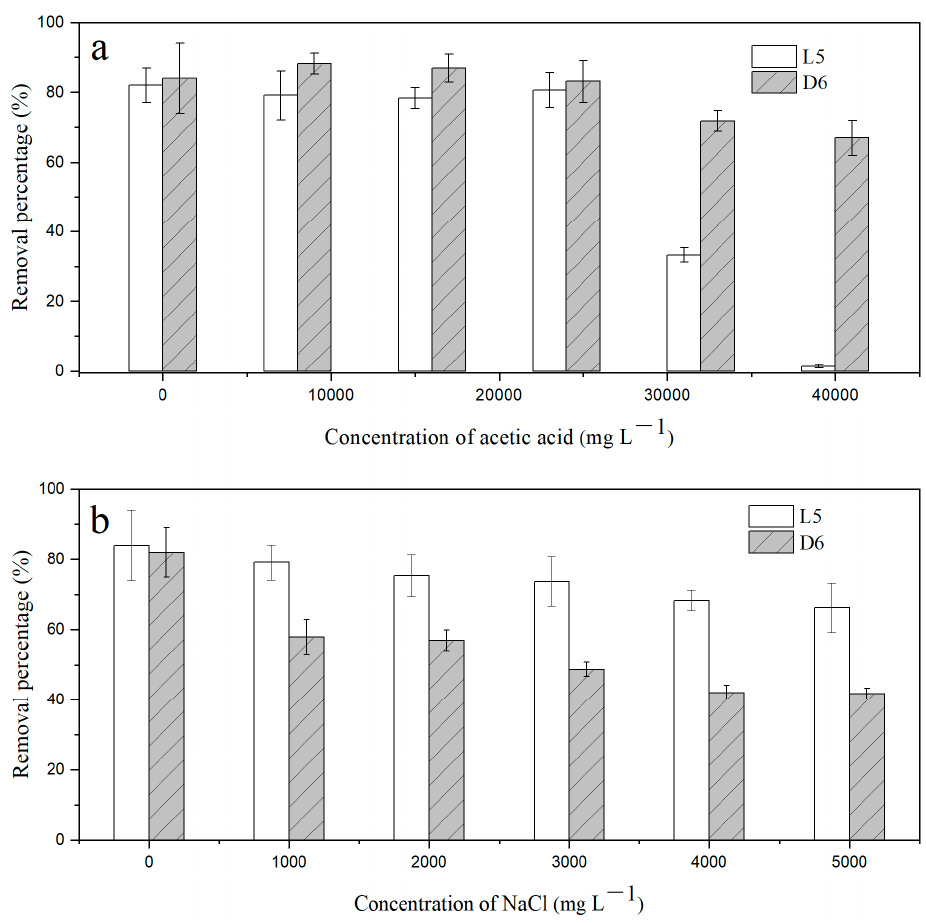
Figure 7. Effect of the acetic acid ( a ) and inorganic ion ( b ) on the adsorption of L5 and D6 on